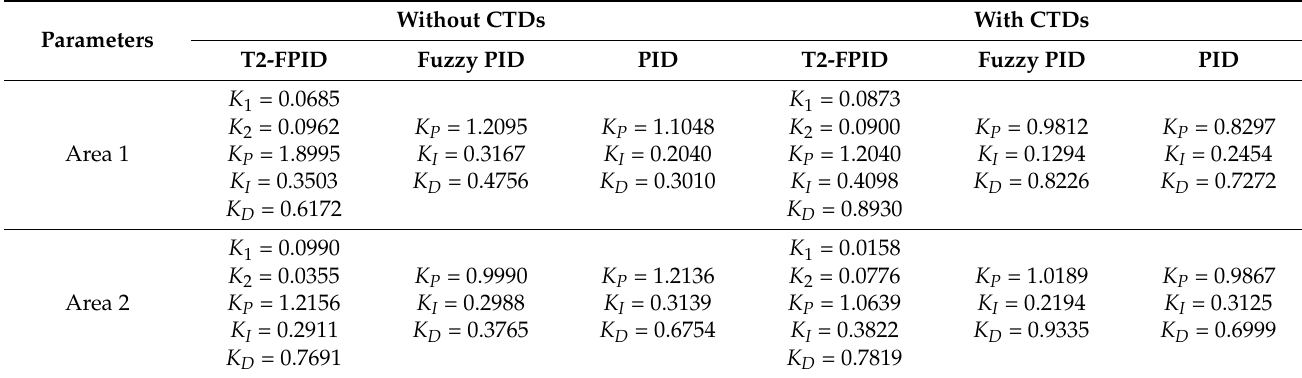
Table 3. Optimal controller gains for test system 2 in various cases.